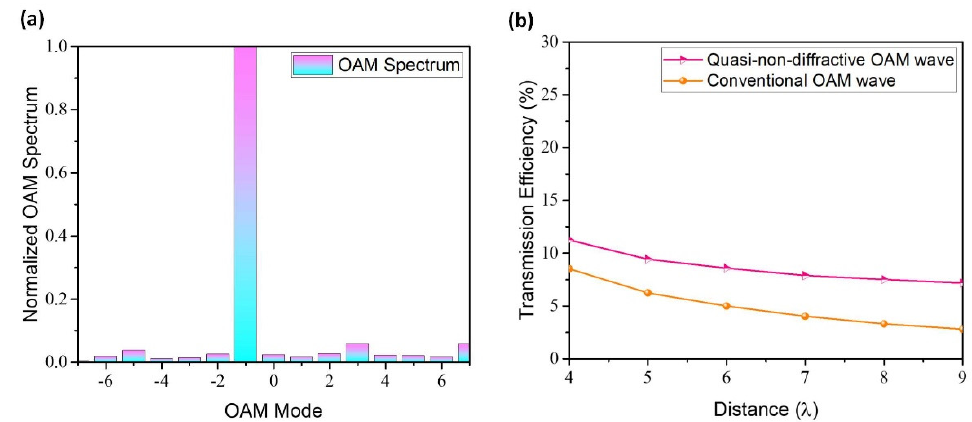
Figure 9. The ( a ) normalized OAM spectrum of the vortex wave carrying l = − 1 mode OAM and ( b ) transmission efficiency of the quasi-non-diffractive and conventional OAM waves.